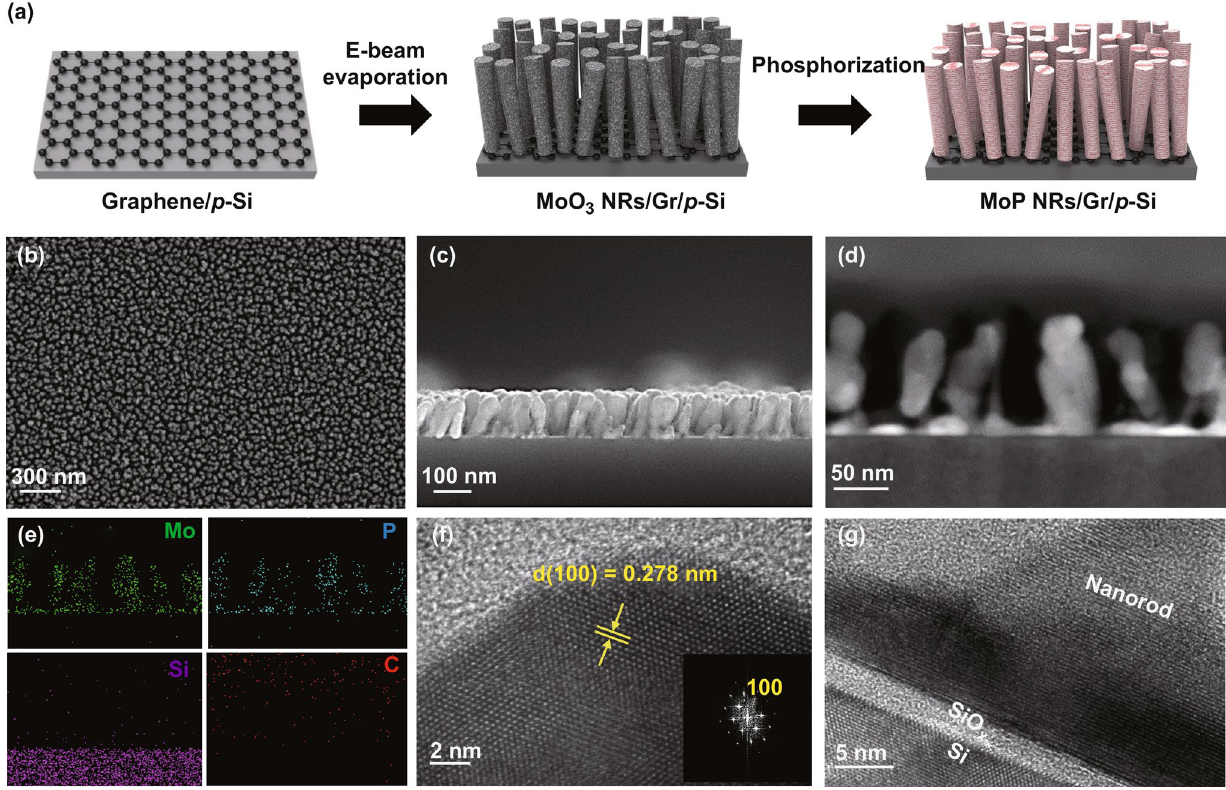
Fig. 2 a Schematic of the synthesis method. b SEM image (top‑view) of MoP nanorods. c Cross‑sectional SEM image of MoP nanorods. d Cross‑sectional STEM image and e EDS element maps of Mo, P, Si, and C for MoP nanorod‑arrays. f High magnification TEM images of MoP nanorod with (100) plane and corresponding fast Fourier transformation (FFT) pattern. g Cross‑sectional TEM image of MoP NRs/graphene/ SiO x /p‑Si surface